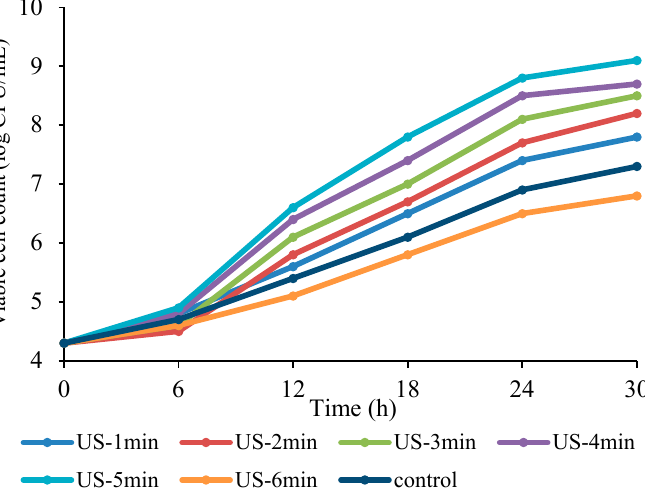
Figure 1. Impact of US on viable cell count in Bakraei juice fermented with L. reuteri . Error bars reveal the standard deviation of viable count in Bakraei juice during 30 h of fermentation. US-1 min: ultrasound treatment for 1 min, Control: non-ultrasound treated juice.